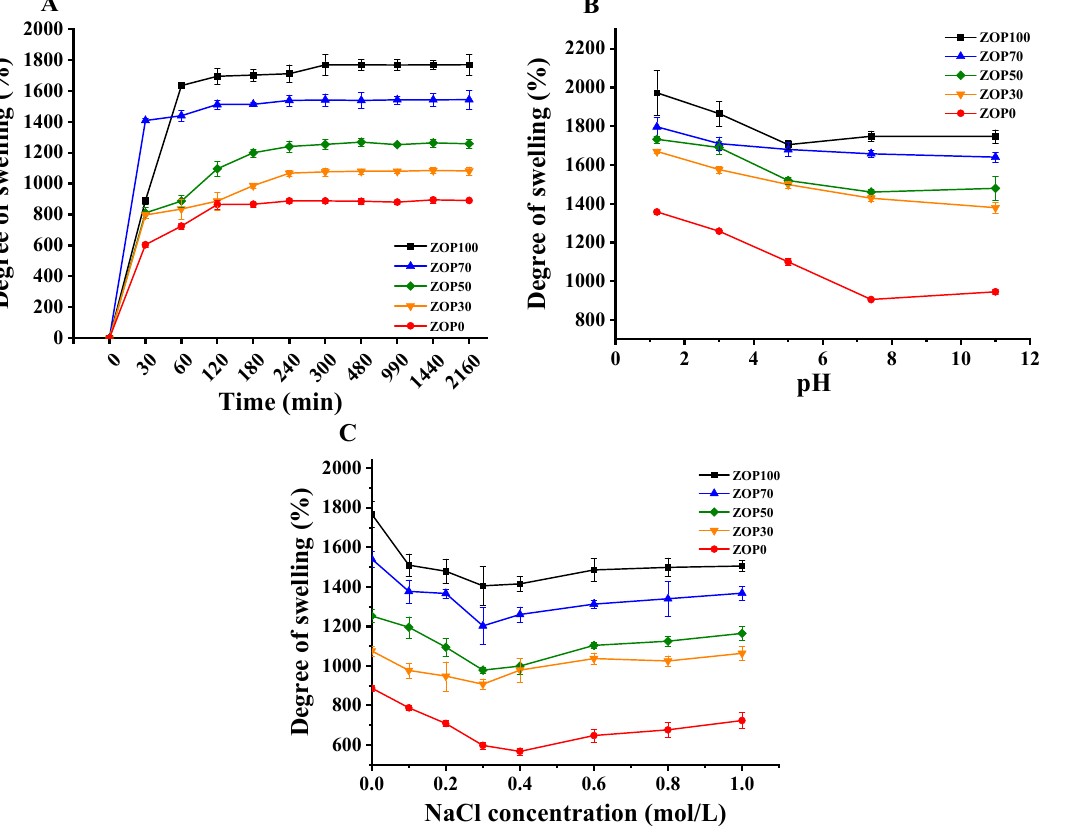
Figure 7. Swelling behavior of the different hydrogels: swelling kinetic curves in deionized water at 25 °C ( A ); swelling ratios values in PBS with pH values ranging from 1.2~7.4 at 25 °C ( B ); swelling ratio values in NaCl solutions with concentrations from 0.01~1 M at 25 °C ( C ).